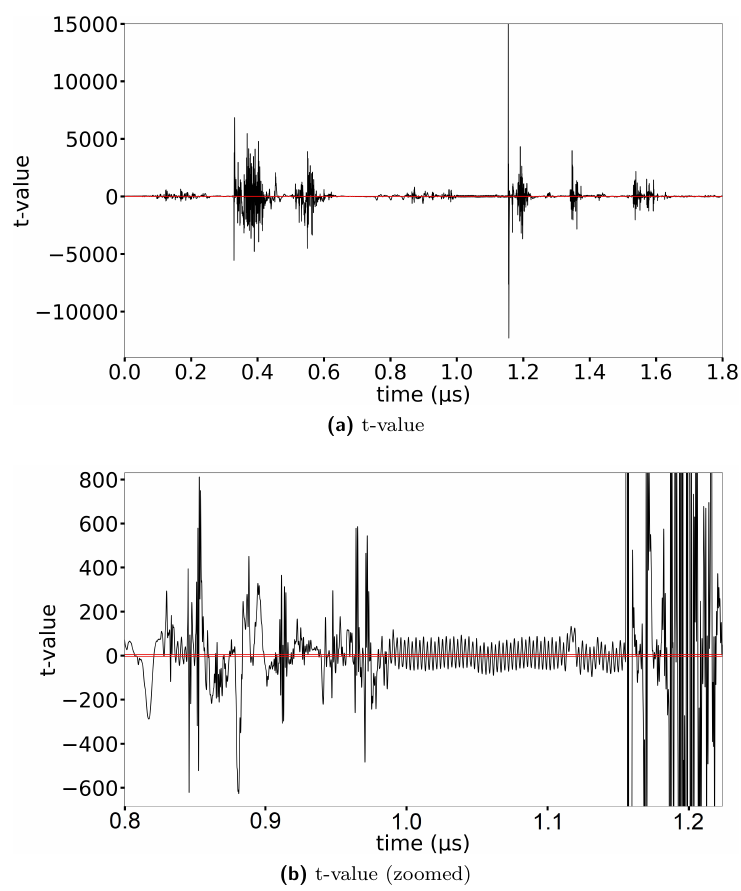
Figure 4: Non-specific